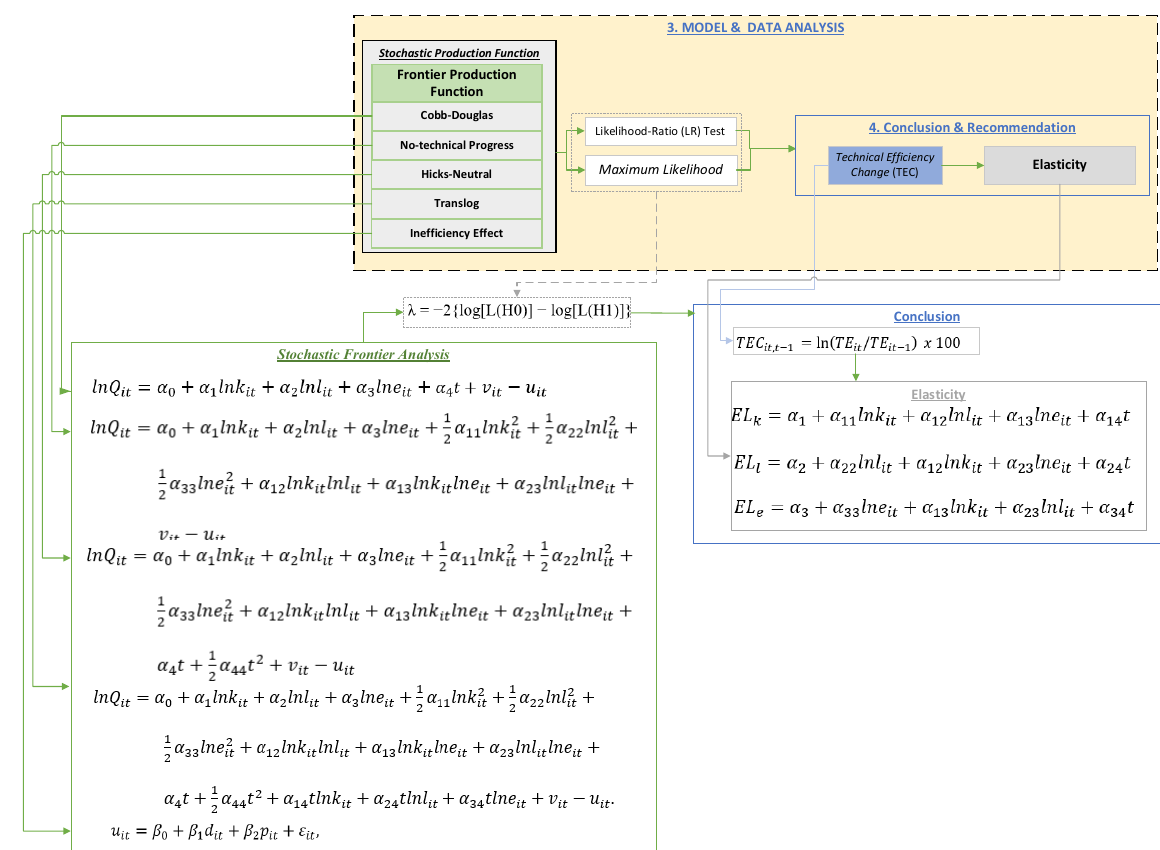
Figure 6: Flow of Calculation of Efficiency and